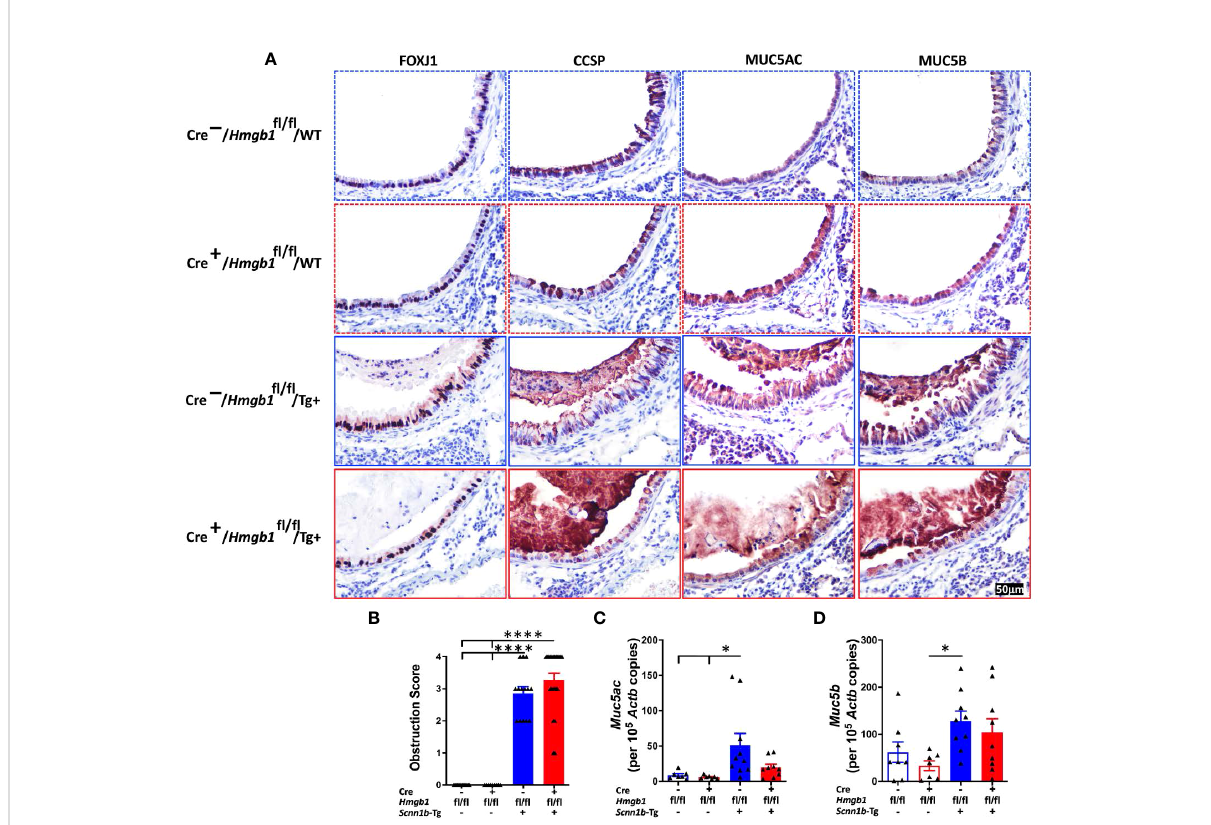
FIGURE 7 Airway epithelial cell-speci fi c deletion of HMGB1 does not alter the airway epithelial cell composition and mucoobstruction. (A) Immunostaining of FOXJ1, CCSP, MUC5AC, and MUC5B in lung sections were performed to check the epithelial cell composition of the four groups (Cre - /WT [blue dotted border], Cre + /WT [red dotted border], Cre - /Tg+ [blue solid border], and Cre + /Tg+ [red solid border] mice). (B) Semiquantitative assessment for mucoobstruction from AB/PAS-stained left lung sections. Absolute quanti fi cation of Muc5ac mRNA (C) and Muc5b mRNA (D) in lung tissues. Different groups are shown as: Cre - /WT (blue open bar), Cre + /WT (red open bar), Cre - /Tg+ (blue solid bar), and Cre + /Tg+ (red solid bar). Error bars represent Mean ± SEM. One-way ANOVA followed by Tukey ’ s post hoc test was used for the statistical analysis. * p < 0.05, **** p <